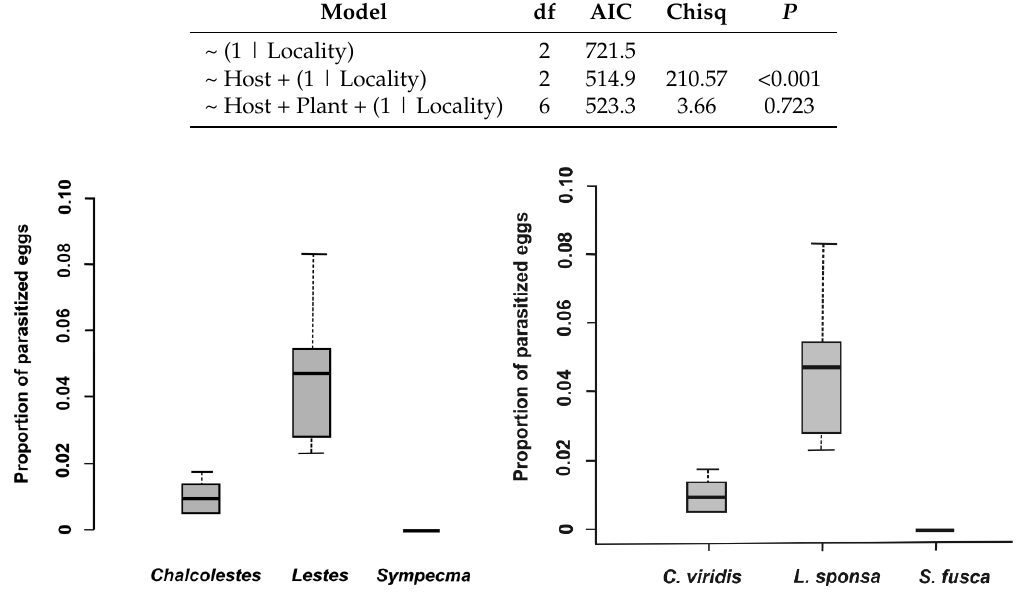
Table 4. Generalized mixed model indicating differences in parasitoidism of lestid eggs in relation to host species and oviposition plant.